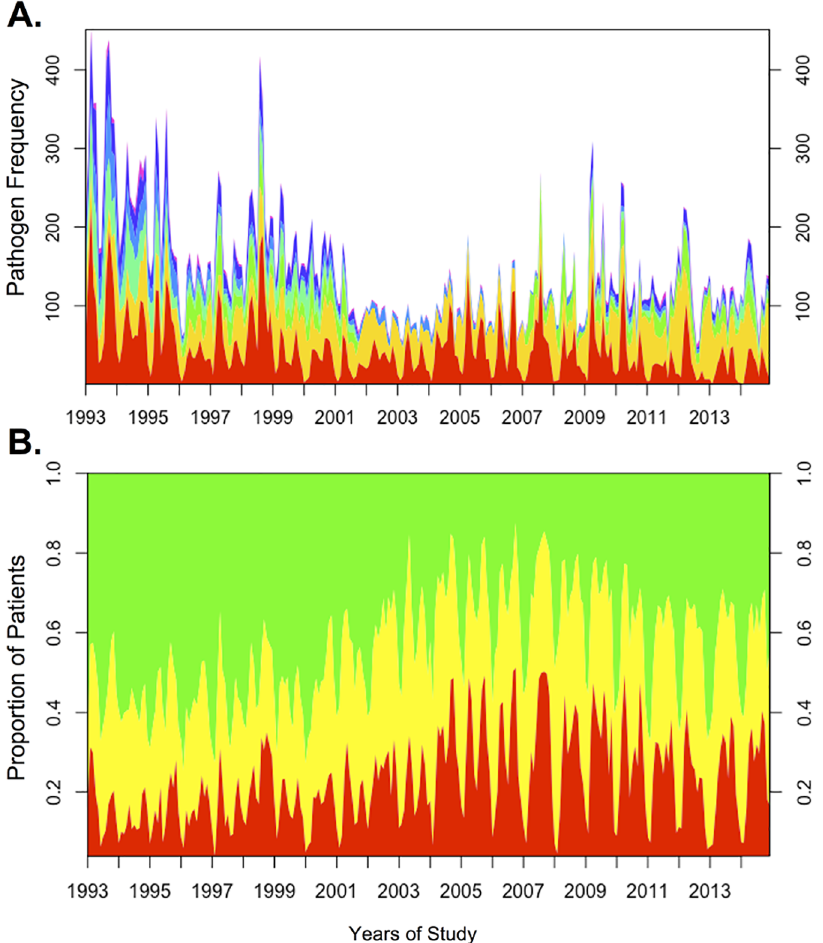
Fig 1. (A) Monthly frequency of pathogens isolatedfrom 1993–2014. Red = V . cholerae; yellow = rotavirus; green = ETEC; blue = Aeromonas spp.; Shigella spp. = purple; Campylobacter spp. = orange. Non-typhoidal Salmonella = black. Surveillance enrollmentrates were 4% for 1993–1995and 2% for 1996–2014. (B) Proportionof patients presentingwith severe (red), some (yellow),and no (green)dehydrationacross the study